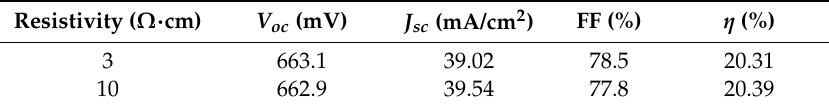
Table 3. IV results of FFE IBC